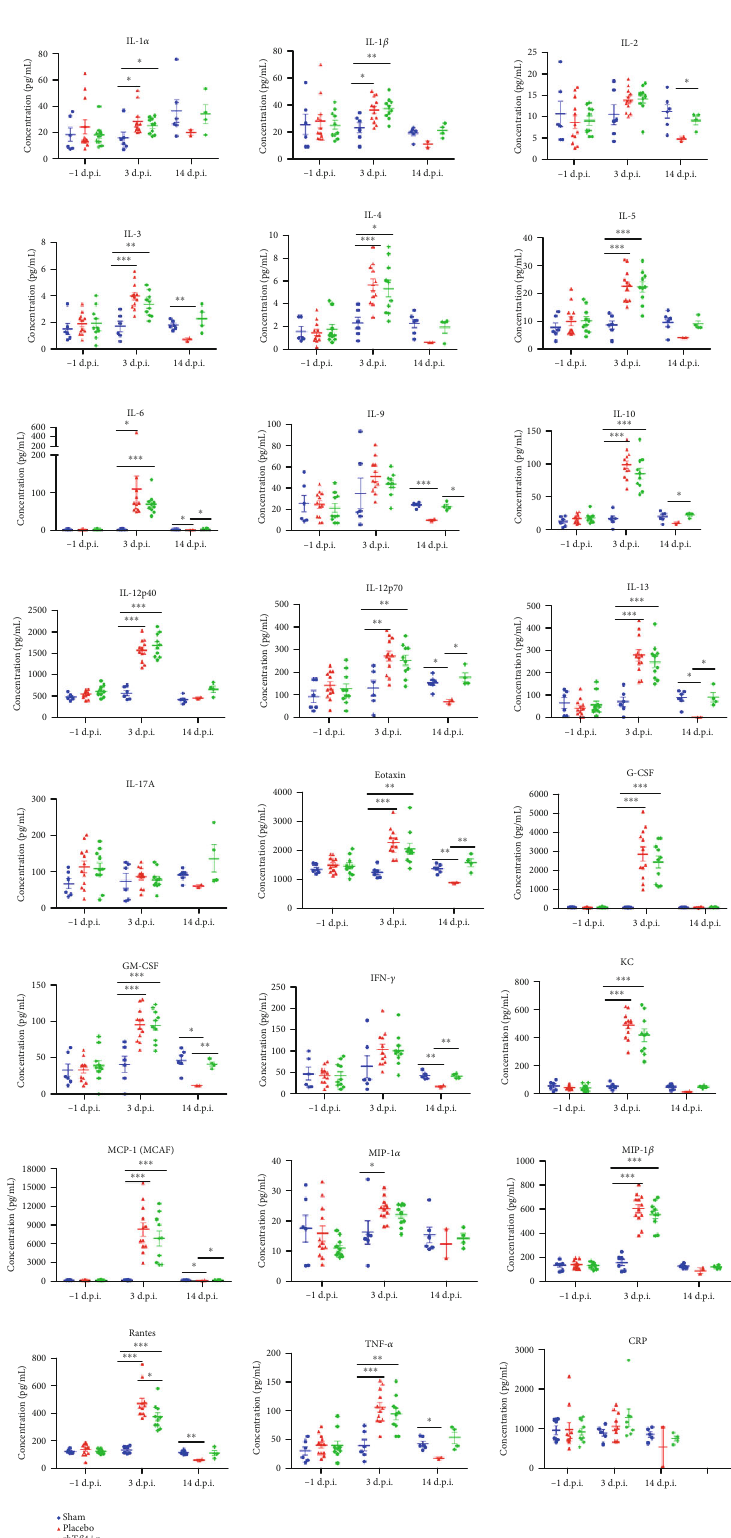
Figure 5: The cytokines and CRP concentrations in the mice serum. Cytokines in mouse sera were detected using a Bio-Plex Pro Mouse Cytokine 23-plex Assay Kit. The CRP concentrations in mouse sera were measured using a Mouse C-Reactive Protein ELISA Kit. The unpaired t -test was used to compare two group data. ∗ P < 0 : 05 , ∗∗ P < 0 : 01 , and ∗∗∗ P < 0 : 001